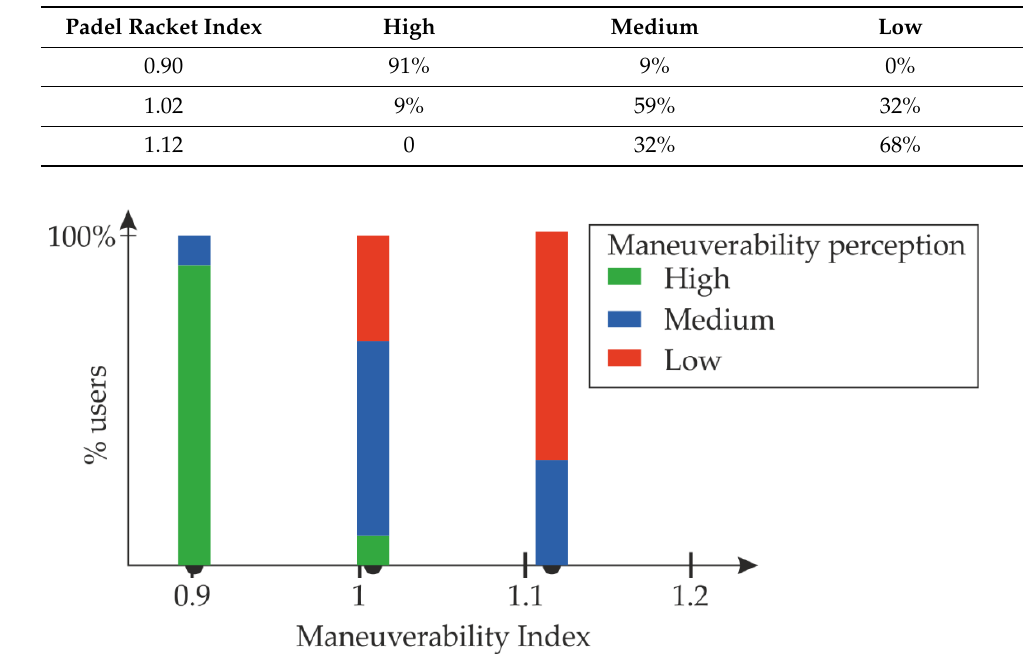
Table 8. Results of the test with users. Each value represents the percentage of users classifying the racket in the category.